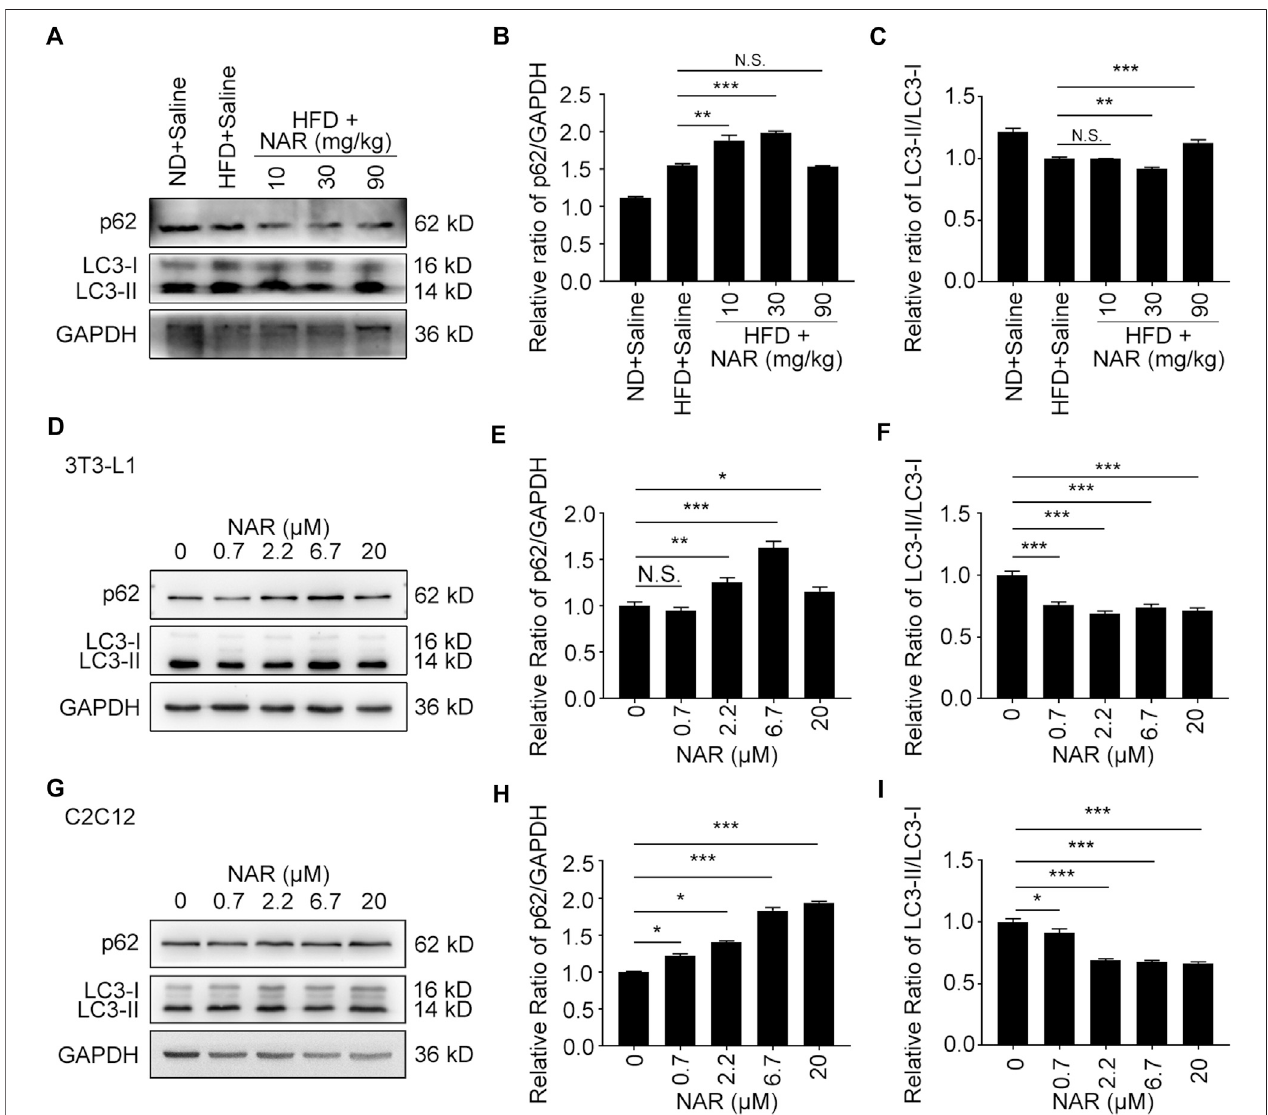
FIGURE 7 | NAR decreases autophagy in livers of HFD-induced NAFLD rats, 3T3-L1 adipocytes, and C2C12 myotubes. The expression of p62 and LC3 in the HFD-induced NAFLD rat livers (A – C) , 3T3-L1 adipocytes (D – F) , and C2C12 myotubes (G – I) after treatment of NAR was detected by Western blotting. All values were expressed as the mean ± SD from three or more independent experiments. *** p < 0.001; ** p < 0.01; * p < 0.05 vs . untreated cells.; Abbreviation: NAR, naringenin; NAFLD, nonalcoholic fatty liver disease; HFD, high-fat diet.